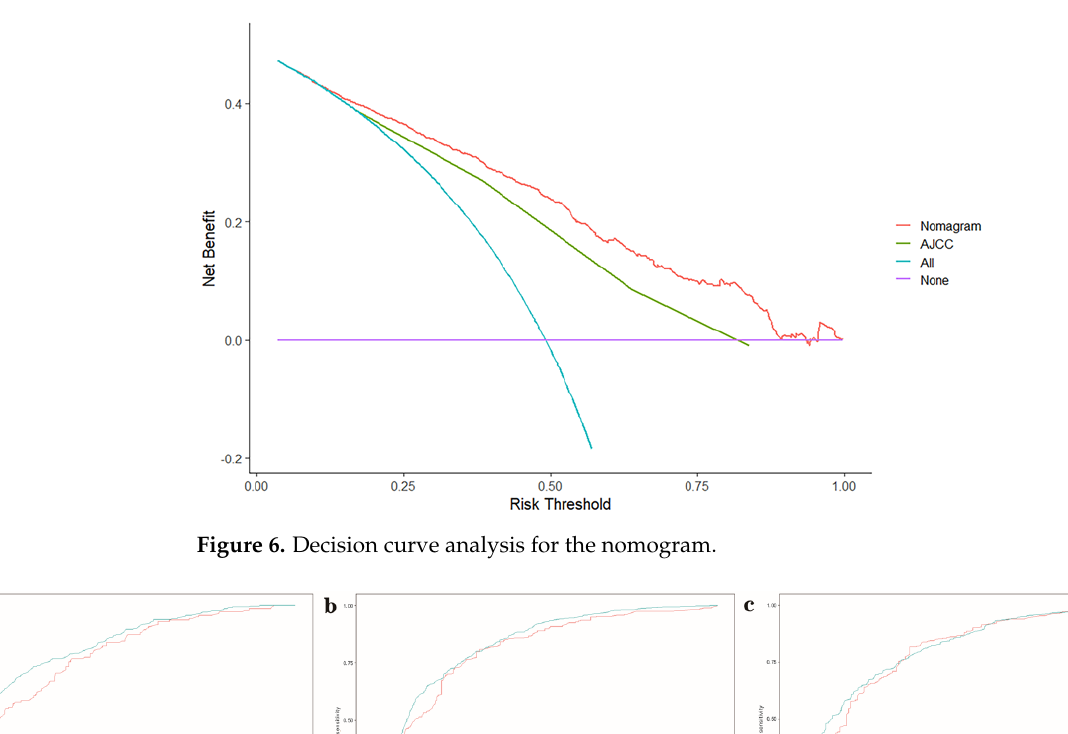
Figure 5. Calibration curves of the model for predicting 1- ( a ), 3- ( b ), and 5-year OS ( c ) in the training cohort and 1- ( d ), 3- ( e ), and 5-year ( f ) OS in the validation cohort.